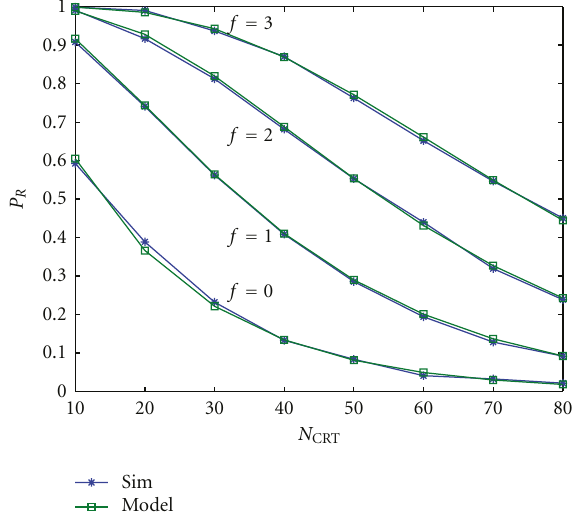
Figure 7: Comparison between P R calculated through analytical model and